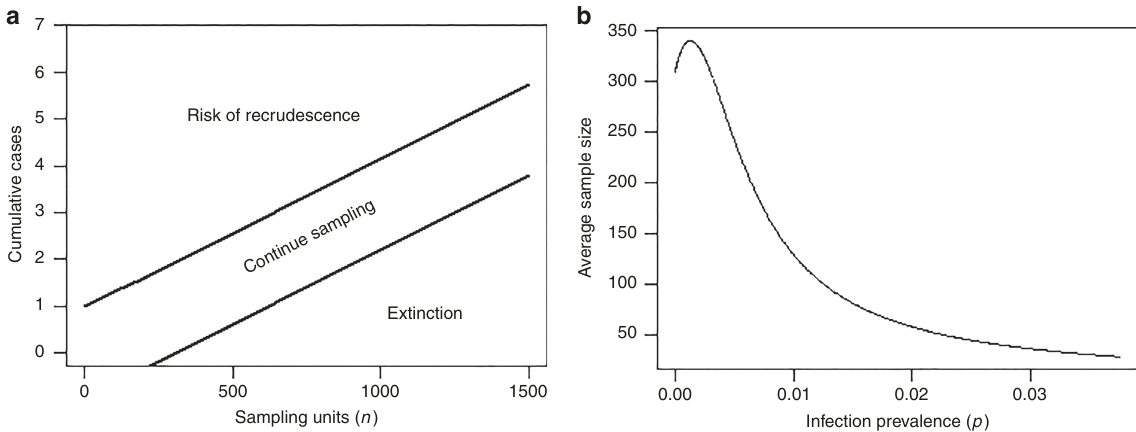
Fig. 4 Sequential entomological sampling for classi fi cation. a Stop lines corresponding to a Wald ’ s sequence probability ratio test (SPRT) 71 sampling plan for classi fi cation based on entomological infection thresholds, as measured by simple random sampling of vectors. Results for a scenario with p 0 = 0.00005 ( = 95% EPT L3 prevalence threshold) and p 1 = 0.0001 ( = 5% EPT threshold), α = 0.05, β = 0.10 are presented. The cumulative total number of sampling units (mosquitoes or black fl ies) assessed as infected (say using dissections) is denoted on the y axis. n is the cumulative total number of sampling units assessed. Sampling units are observed sequentially and the cumulative total of those assessed as infected is noted. The criteria for